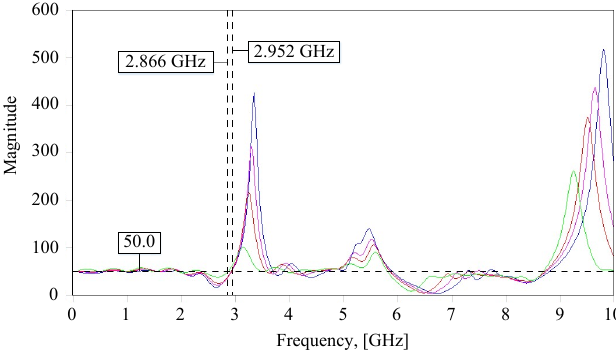
Fig. 5. Input impedance of the meander line, when b = 1.45 mm (blue); b = 1.65 mm (pink); b = 1.85 mm (red); b = 2.3 mm (green); Z 0 = 50 Ω .